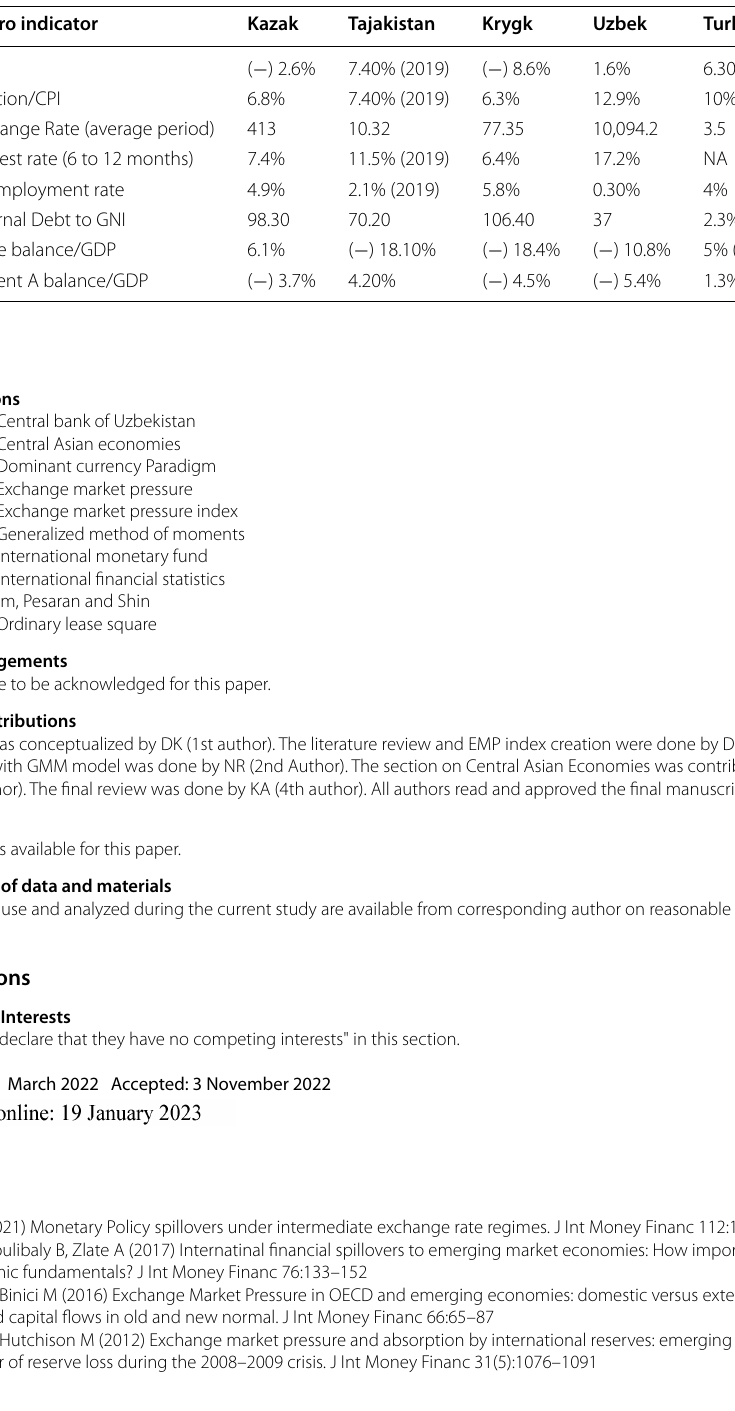
Table 4 Sketch view of macroeconomic profile of CAEs (As on Dec 2020). Source : Asian Development Bank, Key Indicators for Asia and Pacific 2021 accessed on 28th June